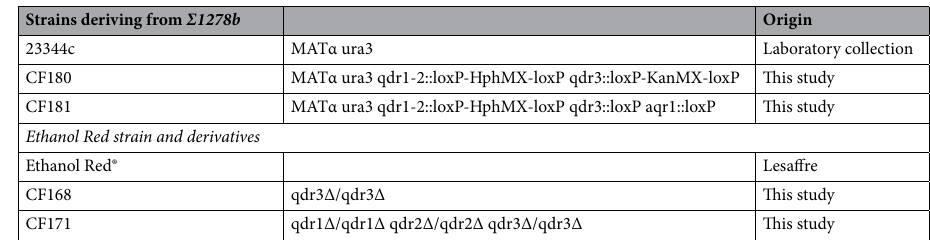
Table 1. Strains used in this study.